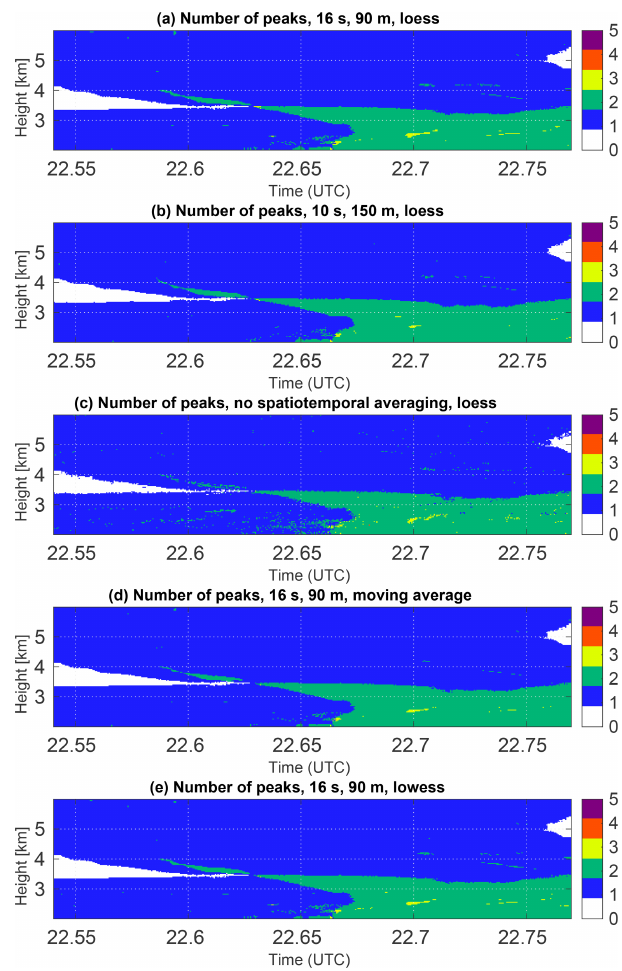
Figure D1. Number of Doppler spectrum peaks detected by PEAKO in five different configurations for the selected case study on 21 February 2014 from 22.54 to 22.77UTC, at 2 to 6km altitude. (a–e) Number of peaks detected by PEAKO in the default configu- ration (16s temporal and 90m spatial averaging prior to loess); this plot is equivalent to Fig. 5a; number of peaks detected using 10s temporal and 150m spatial averaging followed by loess; number of peaks detected without time–height averaging prior to loess; num- ber of peaks detected using 16s and 150m time–height averaging followed by smoothing using the moving average method; number of peaks detected using 6s and 150m time–height averaging fol- lowed by